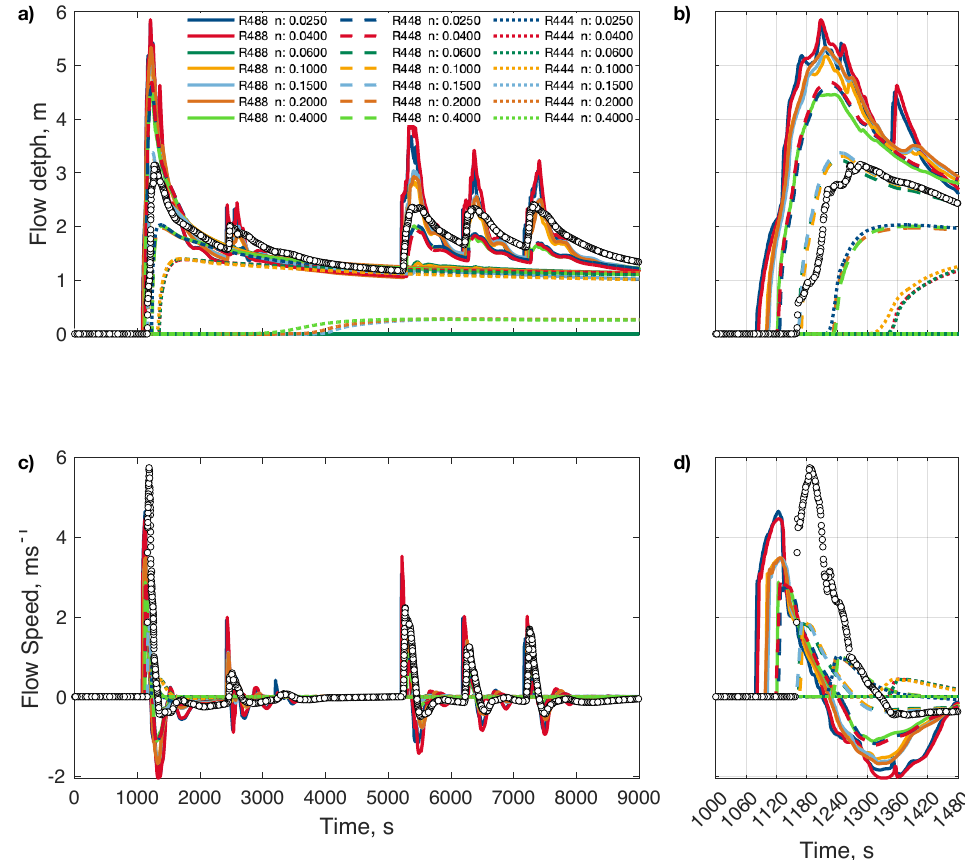
Figure 4. Time series of flow depth d ( t ) ( a , b ) and velocity ( c , d ) at inland gauge 3, for all resolutions R k (line types) and a range of Manning n values (colors). Circles are the reference model. Panels ( b , d ) are zoomed in near the first